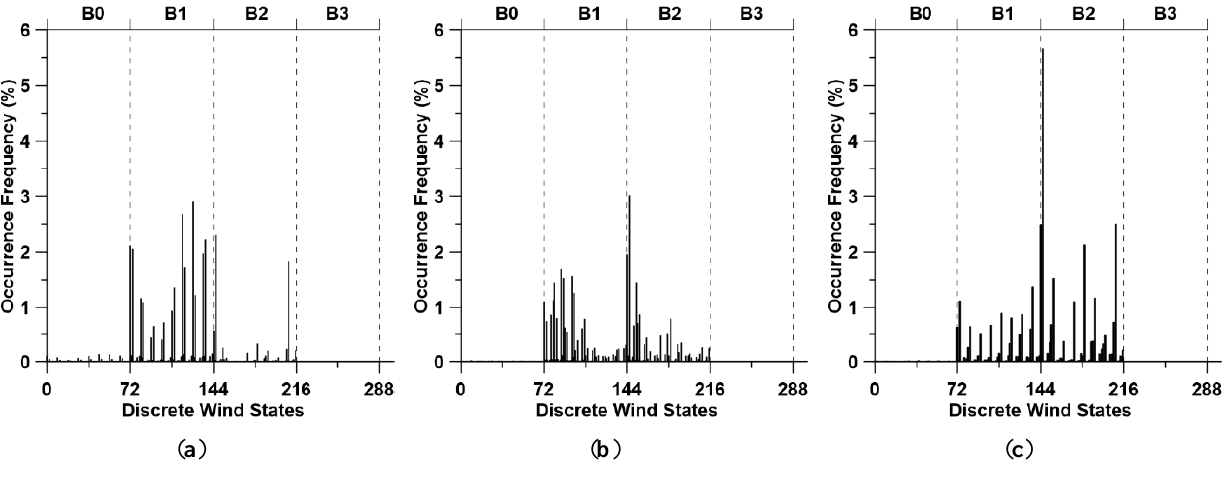
Figure 8. Occurrence frequencies of Mexico City discrete wind states. ( a ) 00-07 CST (early morning); ( b ) 08-15 CST (morning and early afternoon); and ( c ) 16-23 CST (late afternoon and night). Each frequency is the percentage of the number of times one discrete wind state was observed in the city, relative to the total number of wind events that occurred throughout the years 2001–2006. Table 9. Absolute percentages of the wind events for discrete values of the wind parameters.